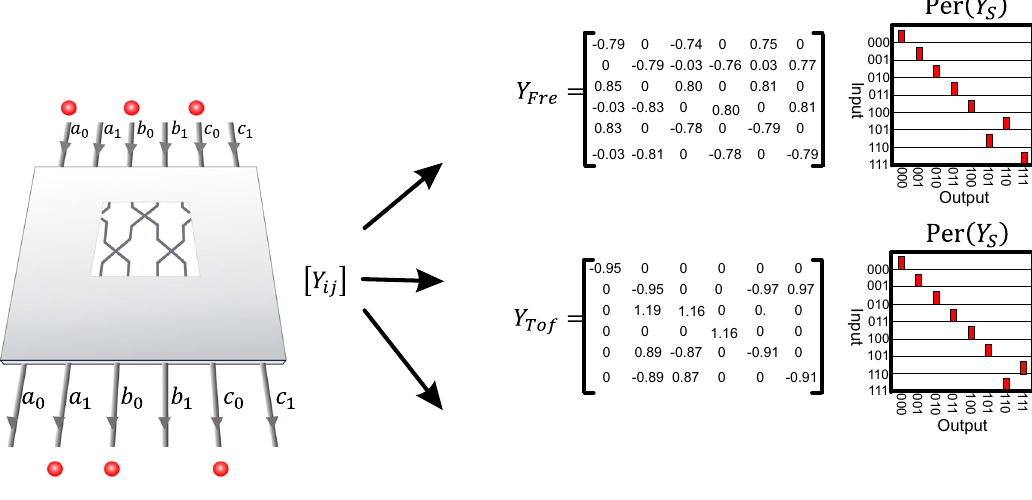
Fig. 1 Scheme of constructing three-qubit quantum logic gates. Three independent photons encoded in a 0 ; a 1 ð Þ ; b 0 ; b 1 ð Þ ; c 0 ; c 1 ð Þ pass (cid:1) (cid:3) through a 6 × 6 photonic circuit described by a nonunitary matrix Y ij , the output distribution of the three-photon coincidence counts at each port is determined by the permanent of the 3 × 3 submatrix Y S de fi ned as Per Y S ð Þ . By calculating the appropriate nonunitary matrix Y Fre and (cid:1) (cid:3) (cid:1) (cid:3)(cid:1) (cid:3) Y Tof for the photonic circuit Y ij , the output amplitude is exactly the matrix X ij of the Fredkin gate and Toffoli gate respectively which infers the implementation of the three-qubit logic gates. Other quantum logic gates can also be reconstructed with the same method by adjusting the nonunitary matrix